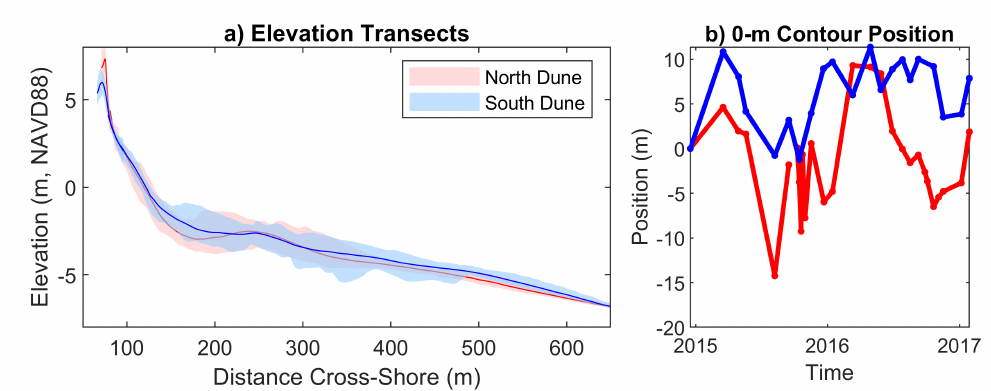
Figure 13. Beach and surf-zone behavior offshore of the north and south dune. ( a ) Average elevation versus cross-shore position for the north (red solid line) and south (blue solid line) profiles during the study. The profile envelop at each cross-shore locations is shown in the shaded regions. The cross-shore location of the north data has been shifted seaward by 25 m so that the mean position of the 0 m contour over the course of the study aligns for comparison purposes. ( b ) The cross-shore position of the 0 m contour for the north (red) and south (blue) regions relative to their respective initial position versus